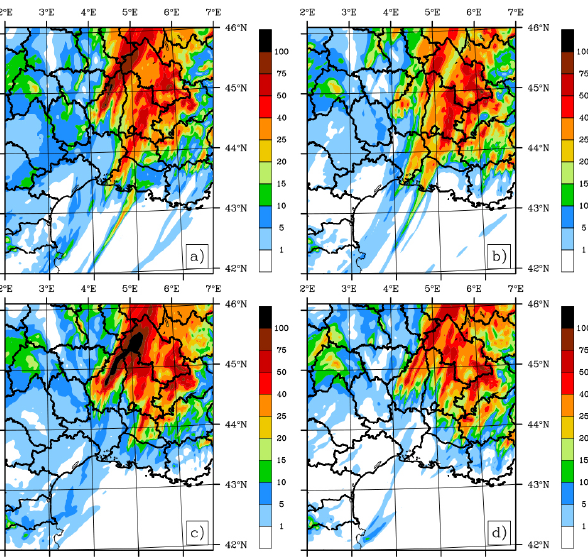
Fig. 9. The simulated daily rainfall amounts (in mm) between 00:00UTC on 26 September and 00:00UTC on 27 September for the AROME (a) , AROME-WMED (b) , ECMWF (c) and ARPEGE (d) members of the ICBC7a